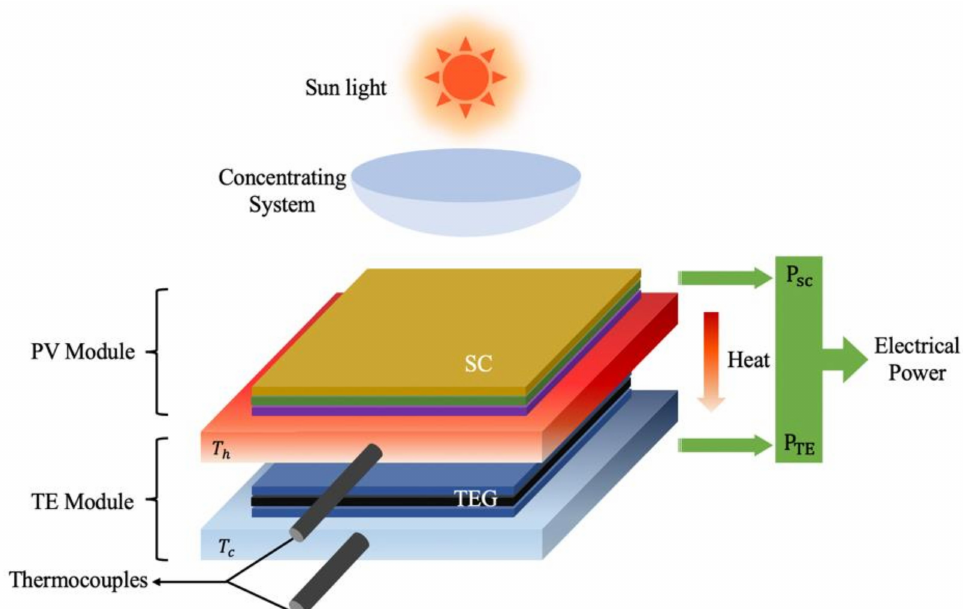
Figure 3. Schematic of a hybrid solar cell/TEG system. PV: photovoltaic; SC: solar cell; TE: thermo- electric; TEG: thermoelectric generator; P sc : electrical power generated by solar cell; P TE : electrical power generated by thermoelectric generator. T h : temperature of the TEG hot plate T c : temperature of the TEG cold plate (adapted from